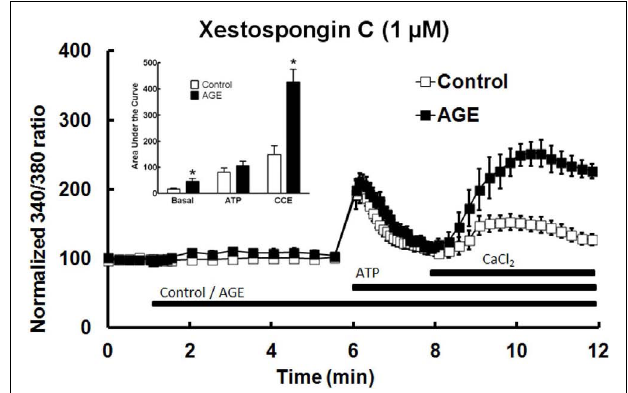
FIGURE 8 | Xestospongin C attenuated the effects ofAGEs on basal [Ca 2 + ] and abolished the effects onATP-induced Ca 2 + release, however AGEs, in the presence of xestospongin C, enhanced CCE. Columns represent the mean ± SEM of six recordings. *Indicates significant effect of AGEs compared to control ( P < 0.05, t